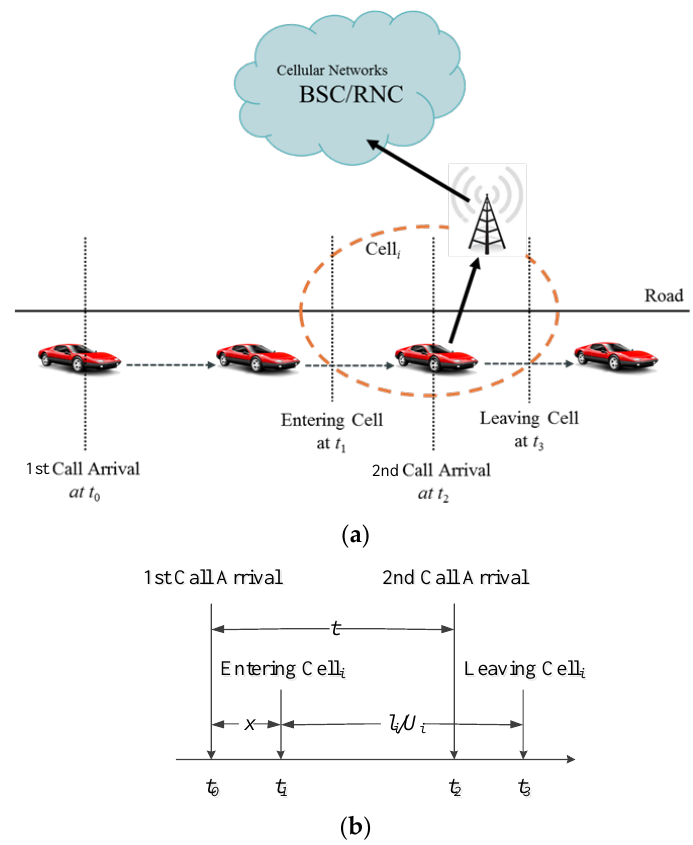
Figure 3. ( a ) The scenario diagram for vehicle movement and call arrivals on the road; ( b ) the timing diagram for call arrivals on the road segment covered by Cell i .